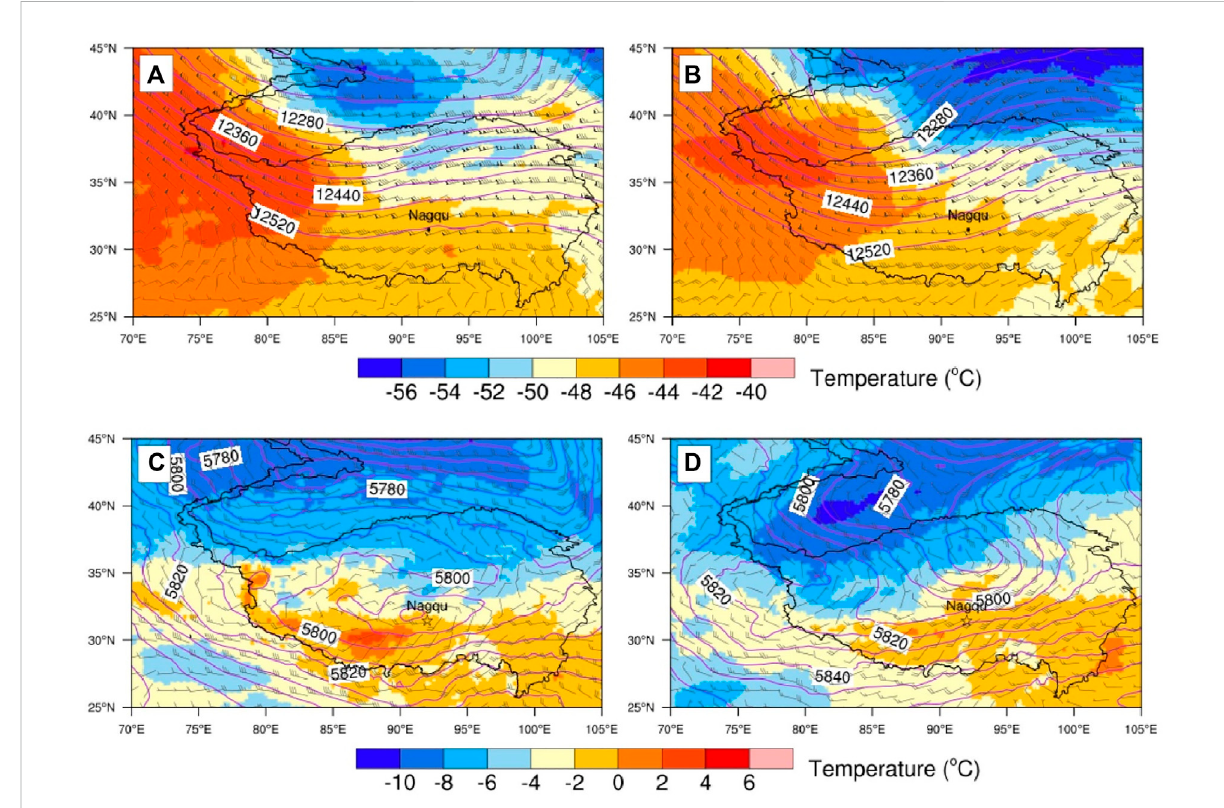
FIGURE 3 200-hPa circulation situation at (A) 0700 UTC on July 14 and (B) 0500 UTC on July 16; 500-hPa circulation situation at (C) 0700 UTC on July 14 and (D) 0500 UTC on July